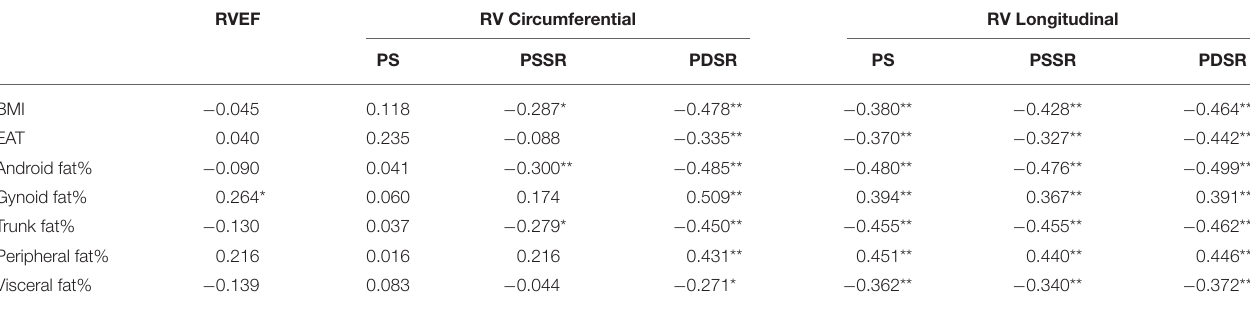
TABLE 5 | Association between regional fat distributions and RVEF and strain parameters in whole population.